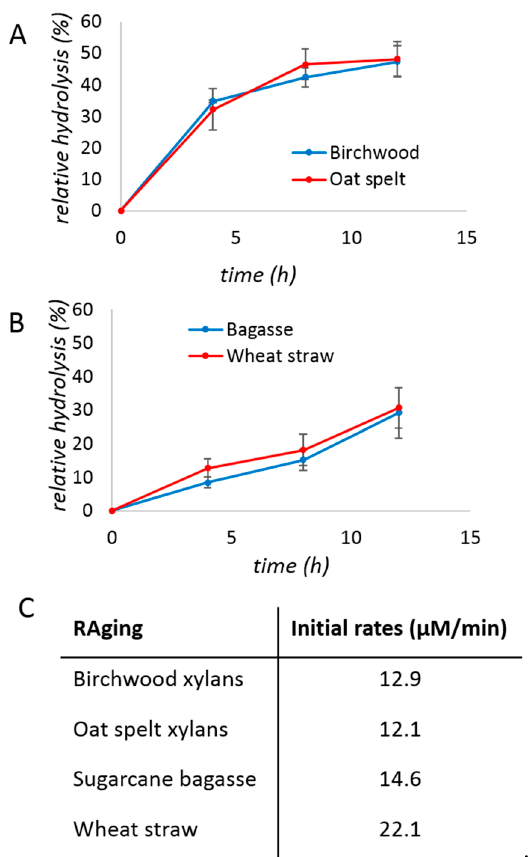
Figure 3. Studies of xylanase reaction kinetics under RAging conditions with ( A ) birchwood (blue) or oat spelt (red) xylans, or ( B ) sugarcane bagasse (blue) or wheat straw (red), and the corresponding initial rates ( C ). ( A ) the reaction mixtures contained 200 mg of xylan, 50 mg of the commercial xylanase mixture (i.e., 0.2 mg of protein or 0.08% w / w ), and 150 µ L of water. ( B ) the reaction mixtures contained 400 mg of substrate, 100 mg of the commercial xylanase mixture (i.e., 0.4 mg of protein or 0.08%), and 600 µ L of water. The reactions were milled for 5 min, before incubating at 55 ◦ C for 55 min, and repeating this cycle up to 12 times. ( C ) Initial rates calculated for the reactions of panels A and B. Reactions were performed in triplicates and the error bar is the standard deviation.